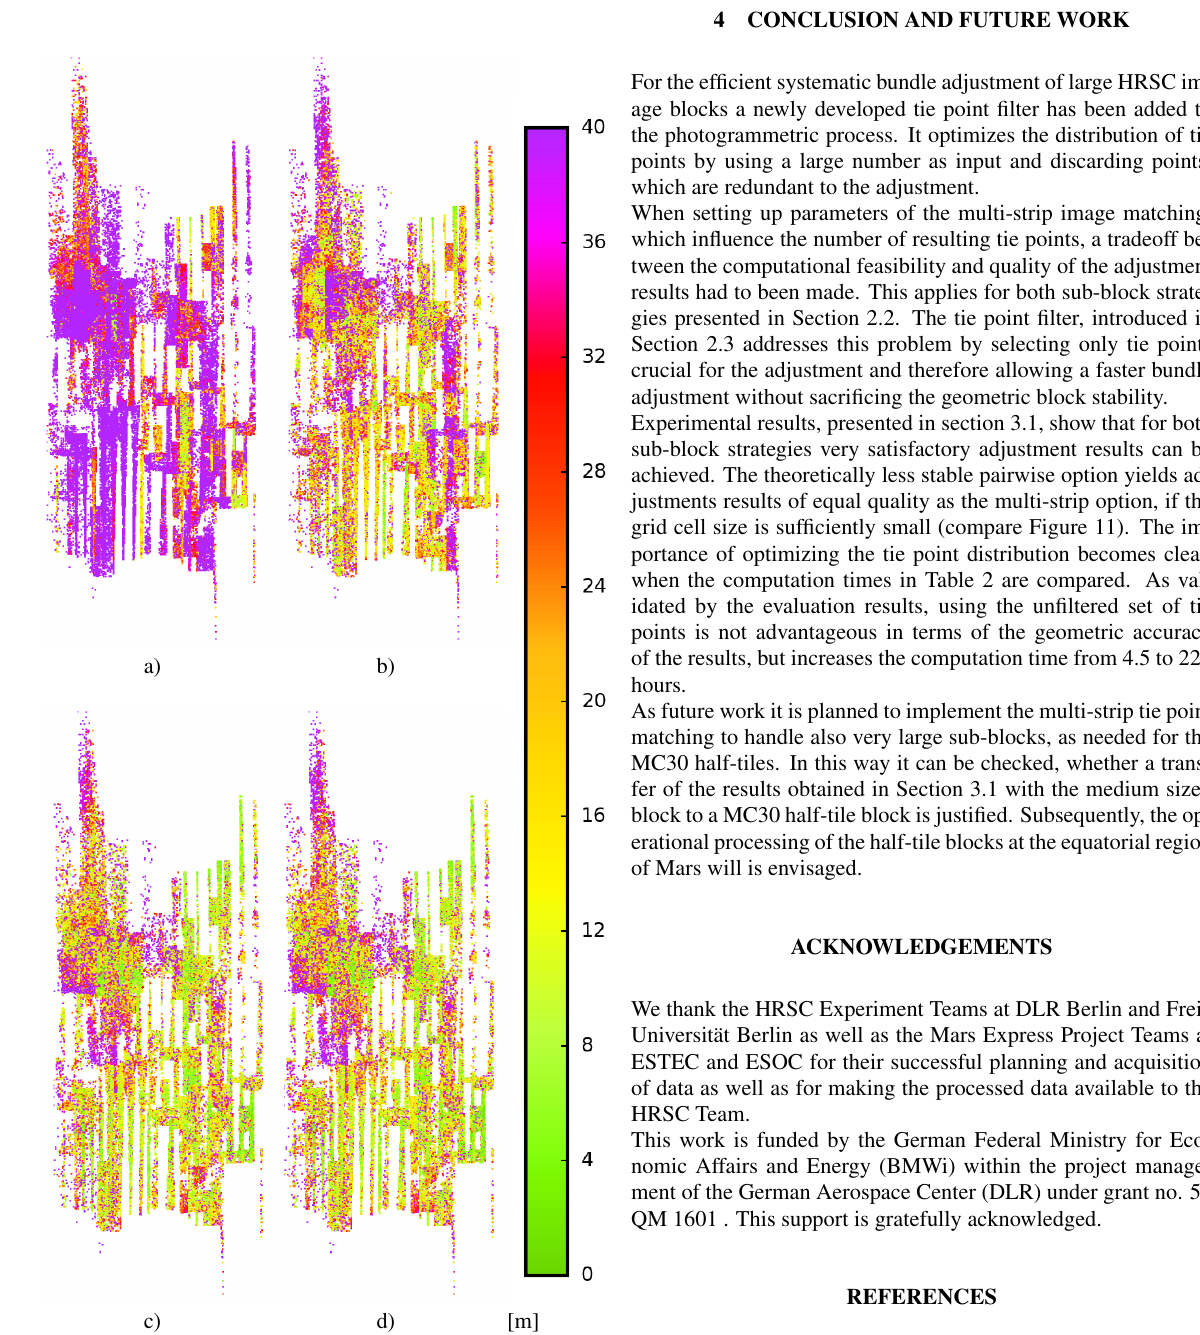
Table 3: Evaluation results for MC-11-E